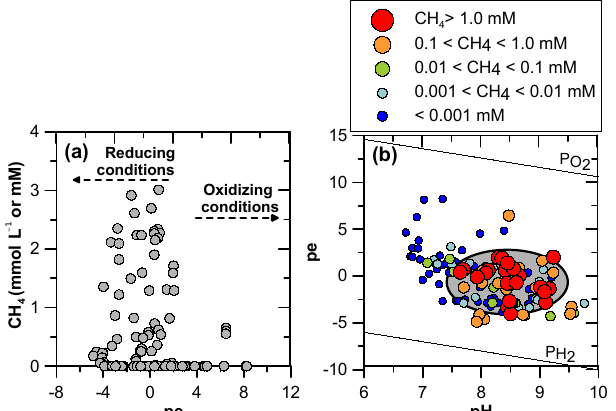
Figure 3. (a) Methane concentrations in water samples vs. pe, (b) pe vs.